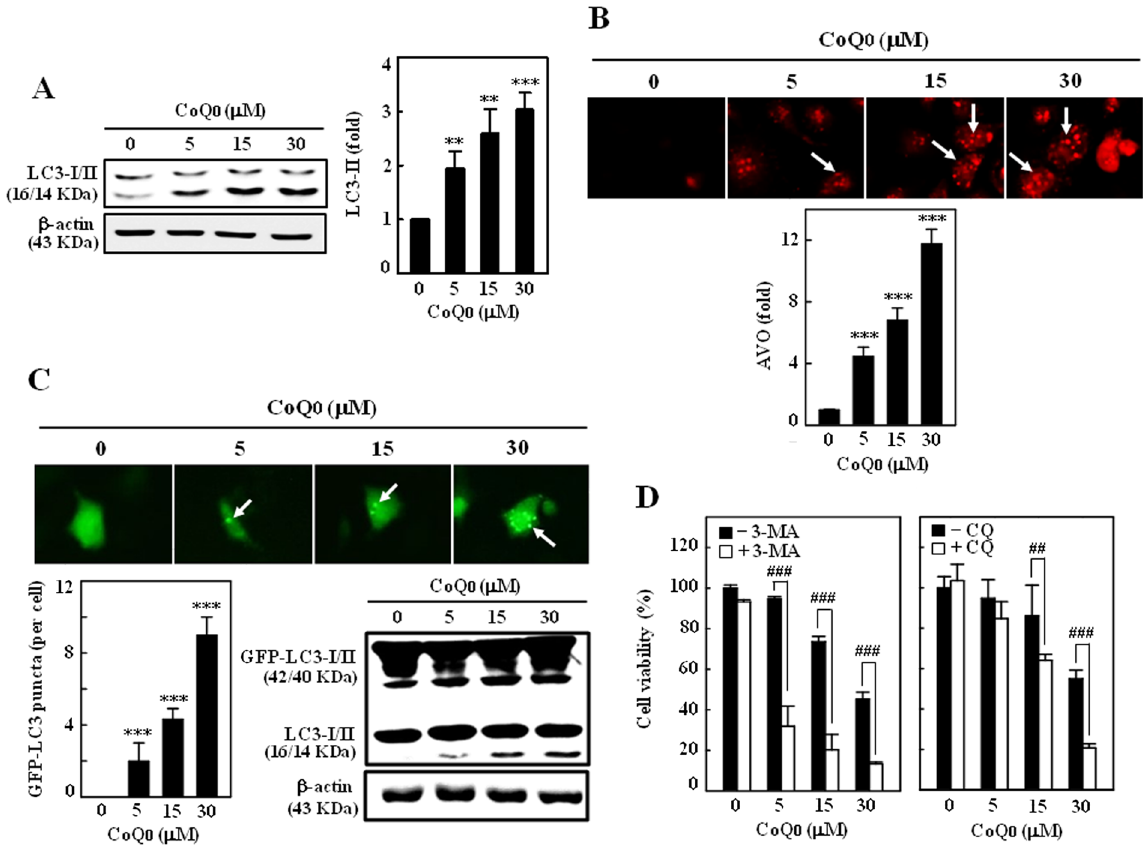
Figure 3. CoQ 0 promotes cytoprotective autophagy as a survival mechanism in SKOV-3 cells. ( A ) Cells were treated with various concentrations of CoQ 0 (0–30 µ M) for 24 h and then conversion of LC3-I to LC3-II was determined by Western blot. Relative changes in the intensities of protein bands were quantified by commercially available quantitative software. ( B ) CoQ 0 induces AVOs formation. Cells were treated with CoQ 0 (0–30 µ M) for 24 h and stained with AO. Formation of AVOs, represented by red fluorescence intensity (in lysosomes) was visualized under a red filter fluorescence microscope (100 × magnification). Number of AO stained cells was presented as histogram, control being as 1.0 fold. ( C ) CoQ 0 promotes conversion of GFP-LC3. Cells were transfected with GFP-LC3 expression vector for 24 h, and then treated with CoQ 0 (0–30 µ M) for 24 h. GFP-LC3 dots in cells were observed under a confocal microscope (200 × magnification). Conversions of GFP-LC3 and endogenous LC3 were determined by Western blot. ( D ) Cells were treated with autophagy inhibitors (2 mM 3-MA or 10 μ M CQ) for 1 h followed by CoQ 0 (0–30 µ M) for 24 h, and viability was assayed by MTT assay. Results expressed as mean ± SD of three independent assays (n = 3). Significant at ** p < 0.01; *** p < 0.001 compared with untreated control, and significant at ## p < 0.01; ### p < 0.001 compared with CoQ 0 alone treated